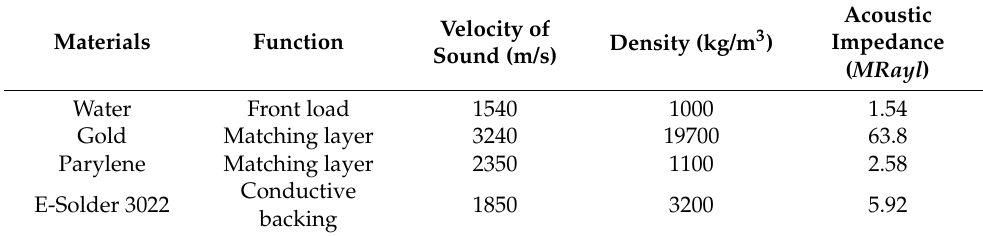
Table 2. Materials properties selected in the transducer design [22].